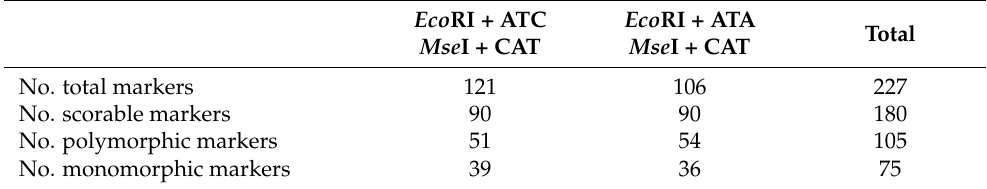
Table 5. Number of AFLPs detected with the primer combinations used to analyze the three Fagus sylvatica provenances.